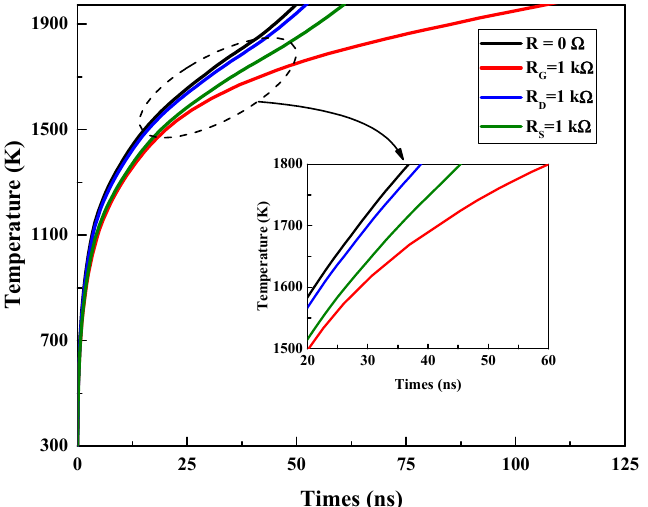
Figure 15. Variation in the maximum temperature ( T max ) inside the GaN HEMT with injection time in different external circuits.